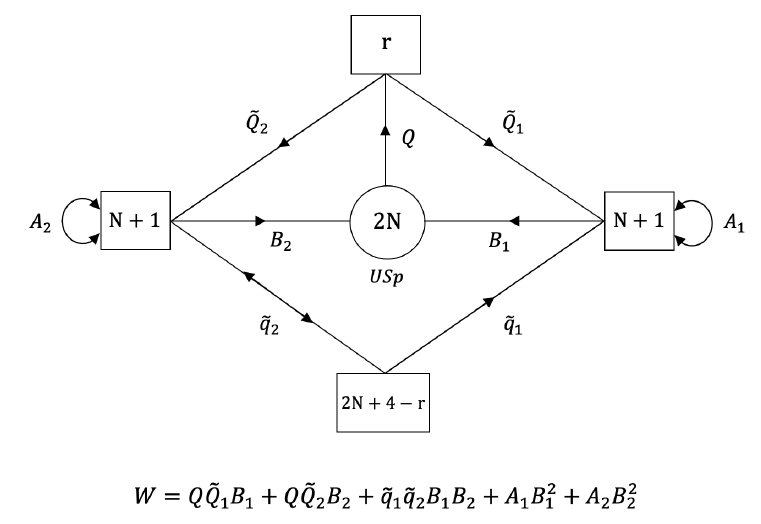
Figure 5 . The 3 d quiver theory associated with the compactification of the 5 d SCFT with SU(2) × SO(4 N + 8) global symmetry on a tube with flux preserving U(1) 2 × SU( r ) × SO(4 N + 8 − 2 r )